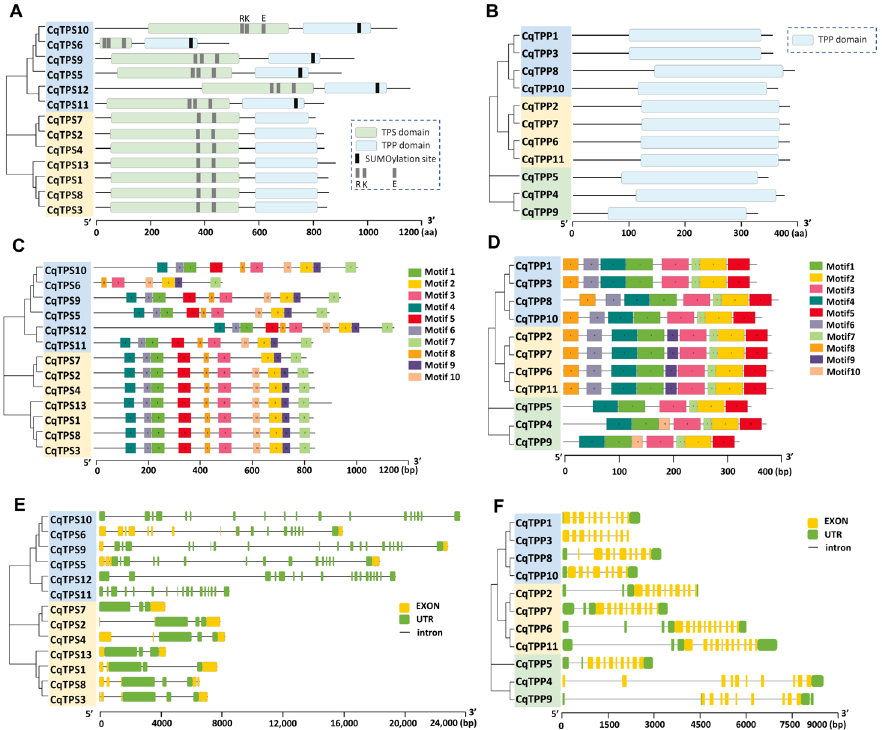
Figure 2. Analysis of gene and protein primary structures of CqTPSs and CqTPPs. ( A , B ) Conservative domain analysis of CqTPS ( A ) and CqTPP ( B ) proteins. Class I CqTPS proteins contain a catalytic triad residue, Arg (R)/Lys (K)/Glu (E) (dark gray bars), and a SUMOylation site at the C-terminal (black bars). ( C , D ) Motif distribution analysis of CqTPS ( C ) and CqTPP ( D ) proteins. ( E , F ) Gene structure analysis of CqTPSs ( E ) and CqTPPs ( F